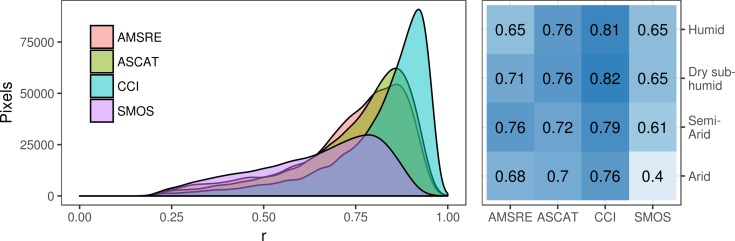
Correlation (r) between soil moisture modelled NDVI and MODIS-NDVI.Left: Distribution shown for all significant pixels. The few values below zero omitted for visual purposes. Right: Heat-map of the average correlation for each dataset used to model NDVI which has been divided into aridity classes; arid (0.03 < AI < 0.2), semi-arid (0.2 < AI < 0.5), dry sub-humid (0.5 < AI < 0.65), and humid (AI > 0.65). Average correlation values shown within heat-map grid.